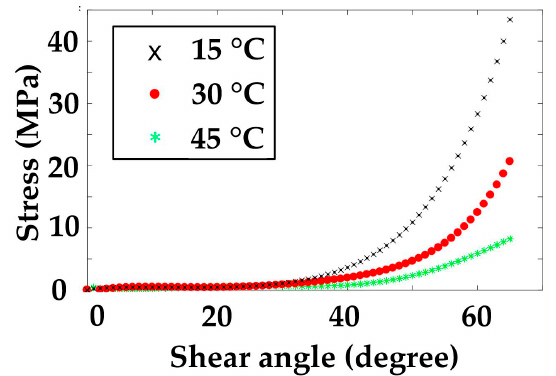
Figure 12. Shear stress–strain curves at three temperatures.